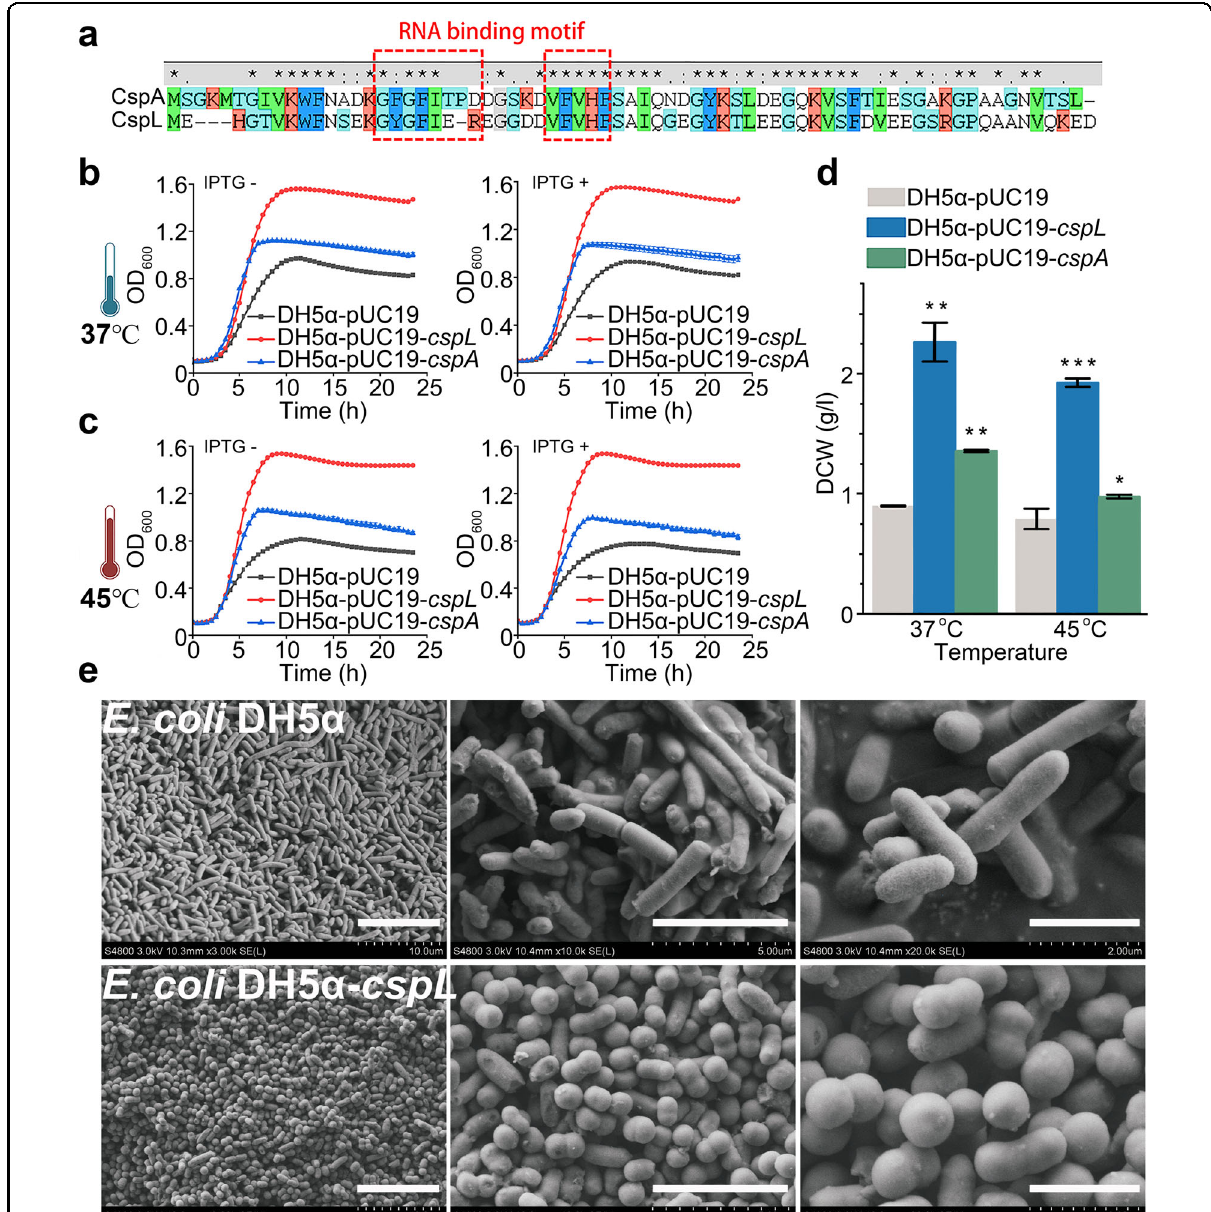
Fig. 2 Functional comparison with homologous gene cspA in E. coli . a Amino acid BLAST reveals that E. coli CspA and B. coagulans 2-6 CspL have 66% identity and share the same RNA-binding motifs. These two binding motifs are highly conserved. b , c , Growth curves of CspL and CspA expressed in E. coli under different treatment conditions, including being induced by IPTG and cultured at 37 °C or 45 °C. d DCW of CspL and CspA expressed in E. coli at 37 °C and 45 °C. Both DH5 α - cspL and DH5 α - cspA ’ s DCW had signi fi cantly improved. e Scanning electron microscopy images of the control (upper panel) and CspL (lower panel) strains cultured at 45